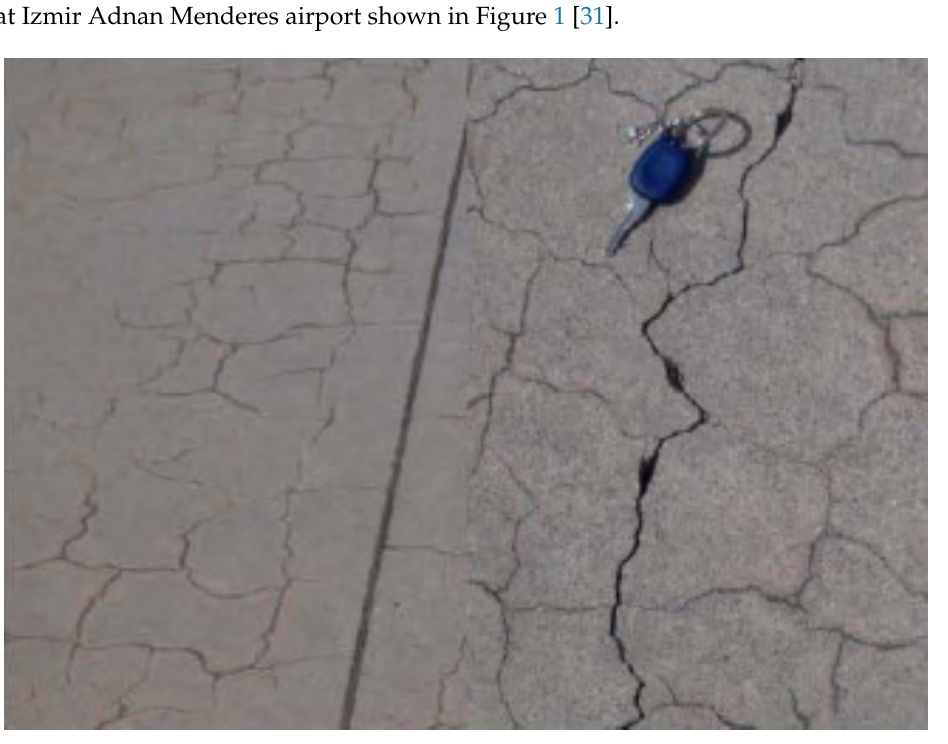
Figure 1. ASR impact on